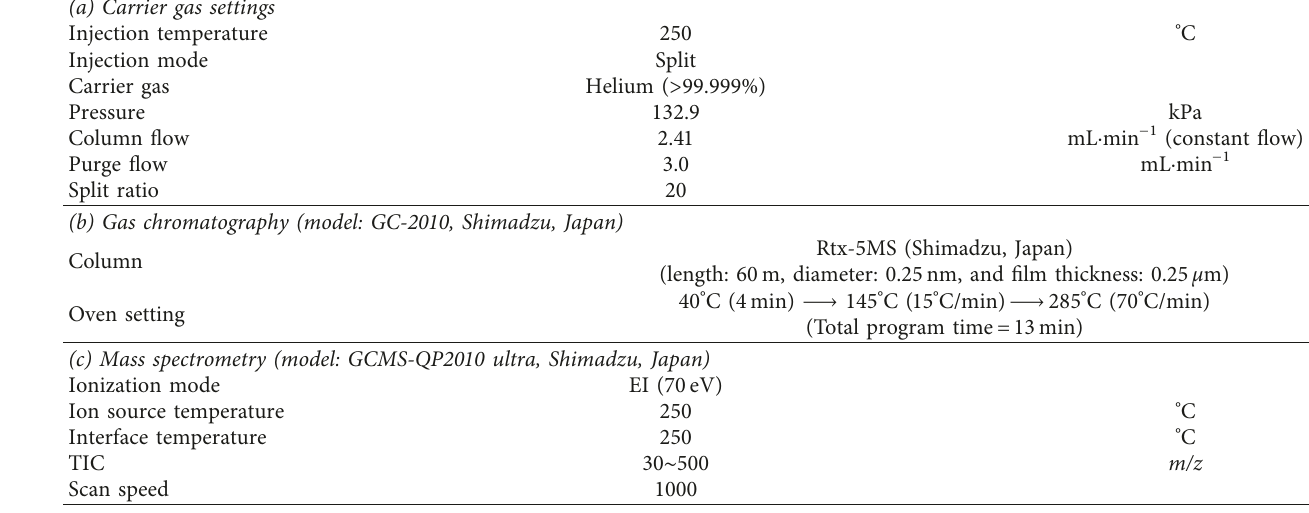
Table 3: Instrumental setup for the analysis of target compounds (B, T, and MIT).